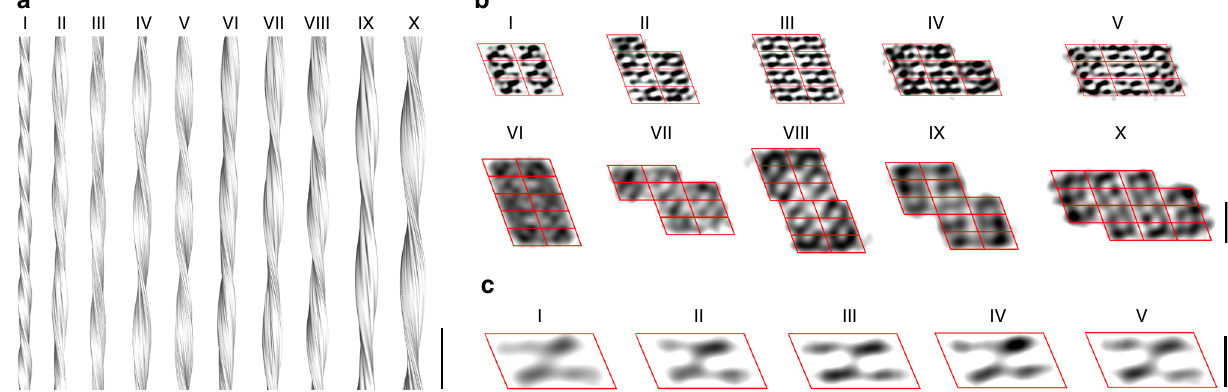
Fig. 1 Structural polymorphism of AL1 peptide fi brils. a Side view of reconstructions of fi bril morphologies I – X (scale bar, 50 nm). b Cross-sectional slices of the reconstructed densities superimposed with a lattice of parallelograms (red). Reconstructions of morphologies I – V were fi ltered to 10 Å and morphologies VI – X to a resolution corresponding to their FSC values at 0.143 (scale bar, 5 nm). c Aligned and averaged parallelograms of morphologies I – V sharing a quasi-twofold symmetry. The data from morphology I were included as published 8 (scale bar, 2